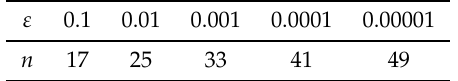
Table 22. Number n of iterations needed by the a posteriori estimate if started with ( 100,20 )